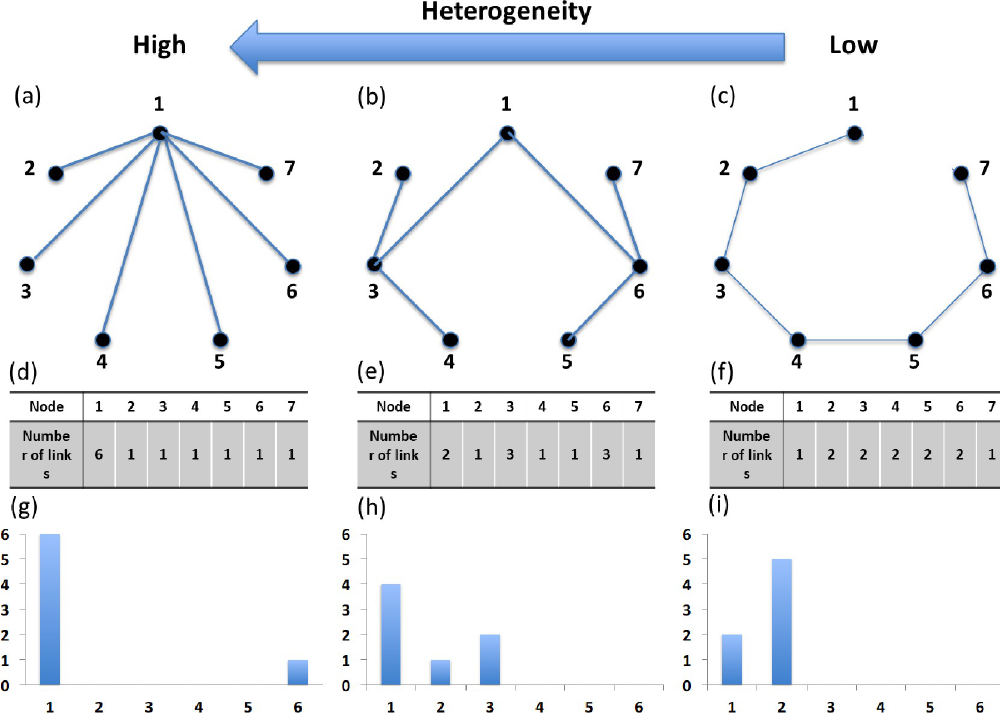
Fig 2. Three kinds of connected graphs (the number of nodes = 7 / the sum of degrees = 12) are based on the heterogeneity of networks. The example network with—(a) high heterogeneity. (b) intermediate heterogeneity. (c) low heterogeneity. The number of links for each node in—(d) the network A. (e) the network B. (f) the network C. The plot (x-axis = the number of links r / the y-axis = the number of nodes with r links) for—(g) the network A. (h) the network B. (i) the network C. There are three kinds of graphs based on the heterogeneity of the networks. If the detection of infected cases connected with detected cases is possible, all susceptible nodes (individuals) in the example network A (on the left side) can be detected for three periods at most. For example, node 2 is detected in period 1. Then, node 1, connected with node 2, can be detected in period 2. Since node 1 is connected with all the other nodes, all the left nodes can finally be detected in period 3. If the first detected node is node 1, all the susceptible nodes can be detected within two periods. However, all susceptible nodes in the example network C (on the right side) can be detected for at least four periods. For example, node 4 is detected in period 1, fortunately. Then, the nodes connected with node 4 (nodes 3 and 5) can be detected in period 2. Similarly, nodes 2 and 6 can be detected in period 3. Finally, nodes 1 and 7 can be detected in period 4. If the first detected node is not node 4, the number of periods required to detect all susceptible cases is more than